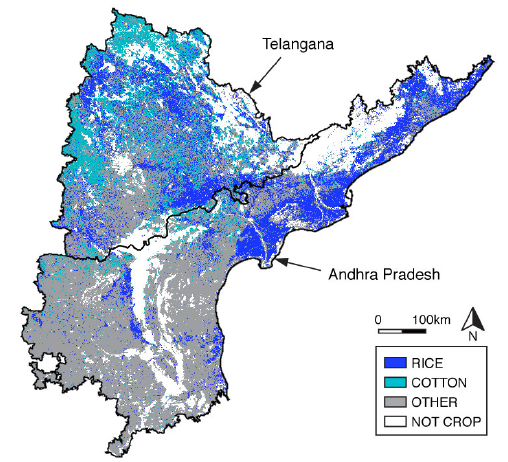
Figure 10. Crop type predictions across Andhra Pradesh and Telangana. Classification results on the three-crop task (rice, cotton, and other crops) are shown across the entire study region. Land designated as non-crop by the Global Food Security-support Analysis Data (GFSAD) cropland product are transparent (white) within the state boundaries. The classification map was created using harmonic features and a random forest classifier in Google Earth